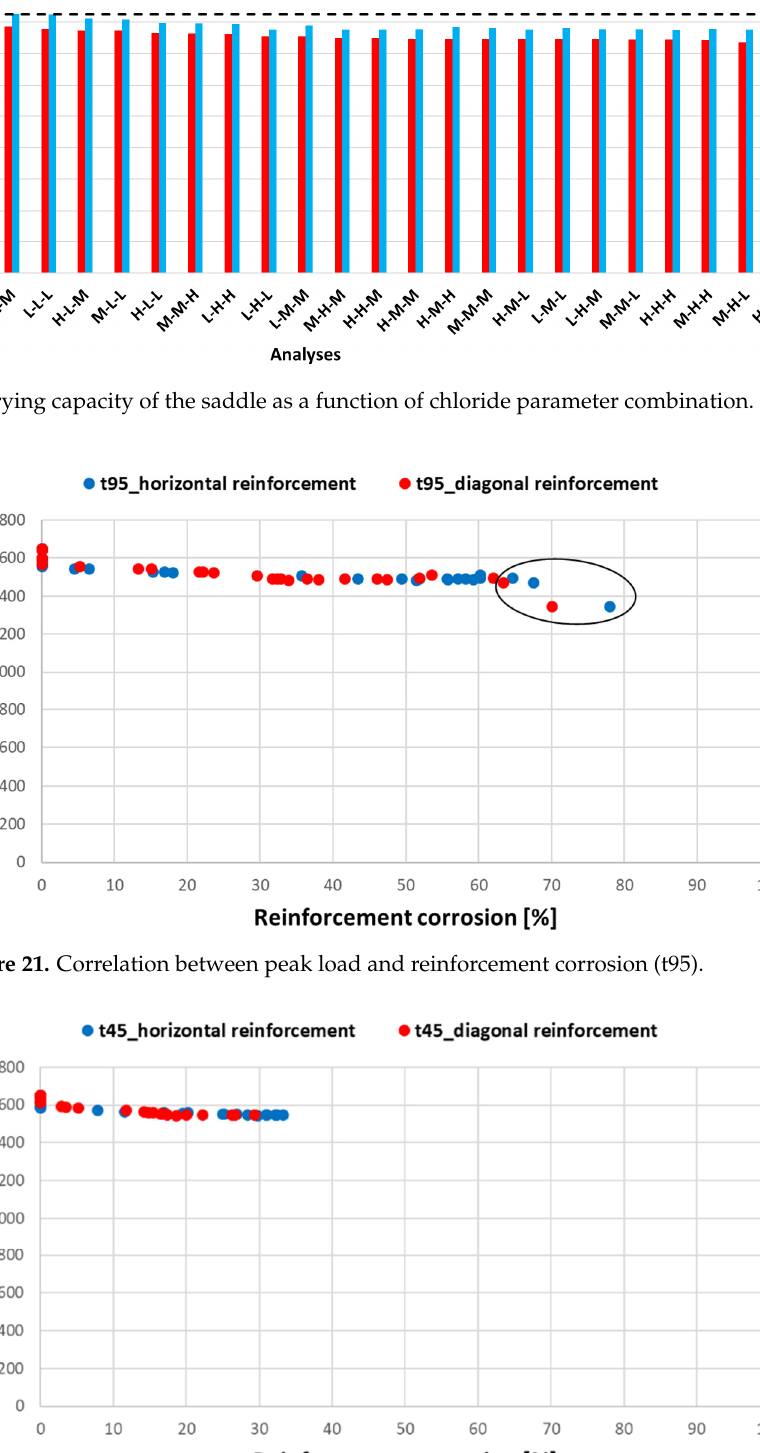
Figure 19. Envelope of load-deflection curves of chloride-induced corrosion analyses at 95 years.